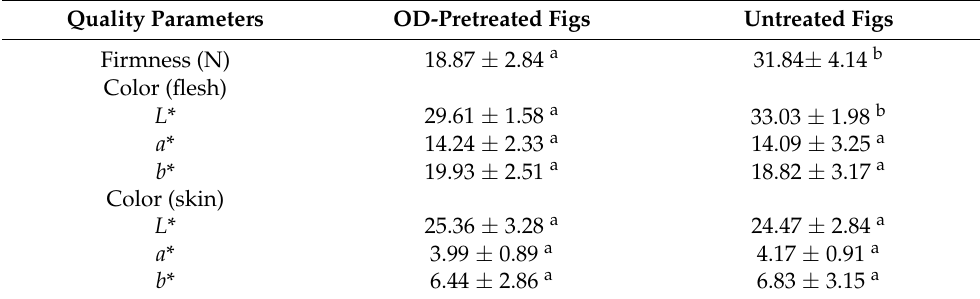
Table 4. Firmness (N) and color ( L *, a *, b *) of OD-pretreated (45 ◦ C, 90 min, 1/4 ratio of sample per OD solution ( w s / w OD )) and untreated dried fig halves.